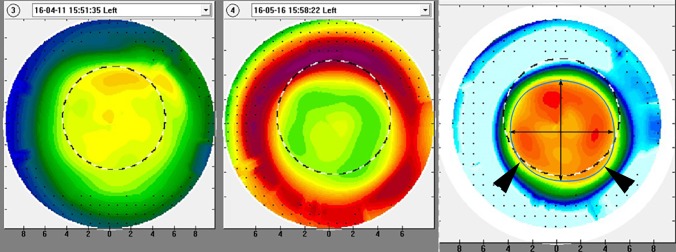
Measurement of treatment zone size.Treatment zone was derived from differential tangential map between baseline and post-OK fitting, which was equivalent to central flattening area surrounded by mid-peripheral annular ring of corneal steepening. Horizontal and vertical diameters of treatment zone were indicated by the lines with arrow heads, and treatment zone was demarcated by the blue circle of best fit indicated by the larger arrow head symbols. Treatment zone diameter and area were measured using pixel length and area from Image J software, which was converted to the mm using the scale provided by in the corneal topography.